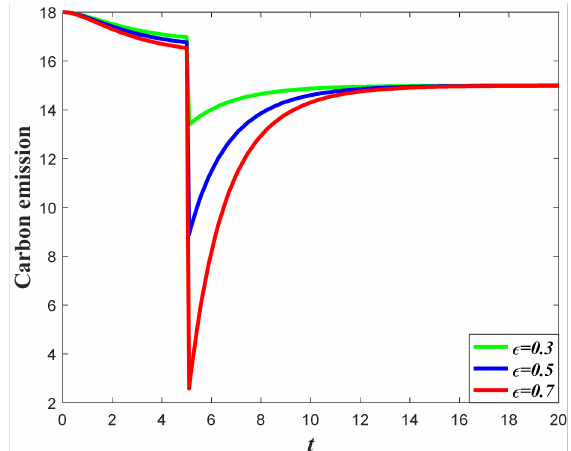
Figure 8. Impacts of ε on carbon emission when Ω 1 ≤ φ < Ω 2